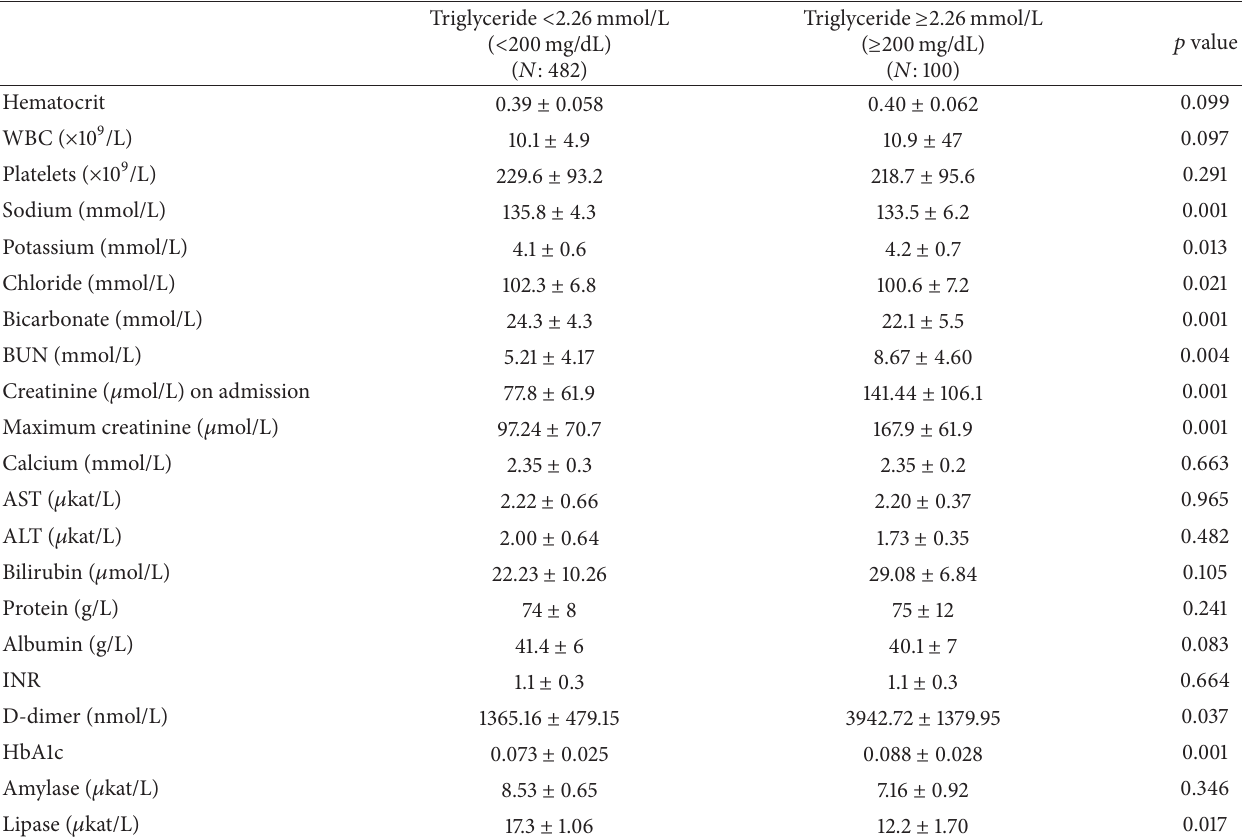
Table 2: Laboratory test values on admission.